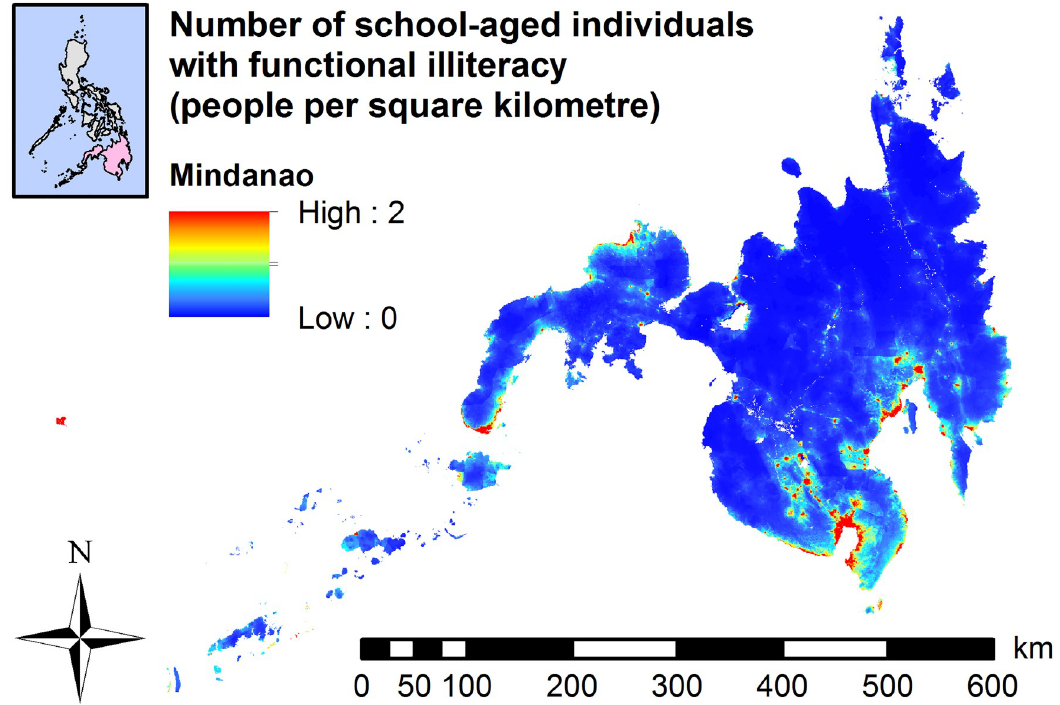
Fig 4. Map showing a total number of school-aged individuals with functional illiteracy, 2017, Mindanao, based on Model 6.